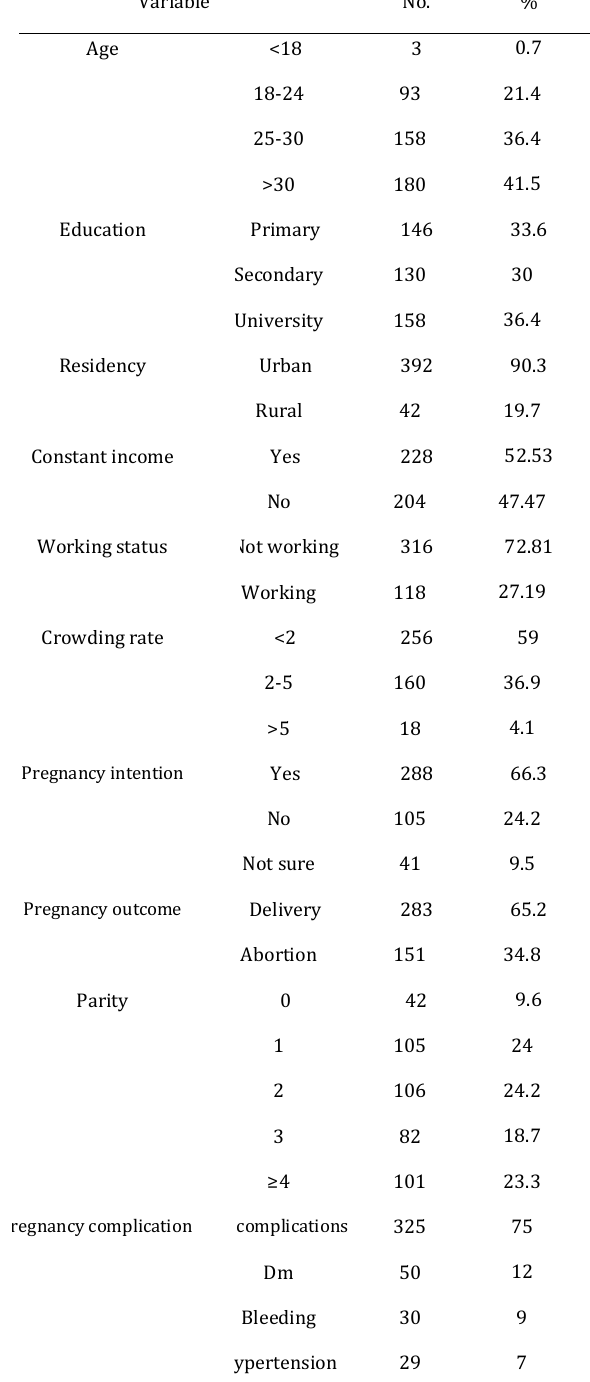
Table 1. : Patients